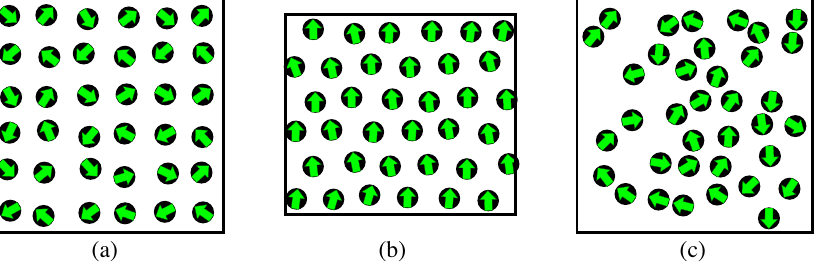
FIG. 1. Ground-state magnetic configurations of representative two-dimensional ensembles of nanoparticles: (a) weakly disordered square structure ( σ r =r 0 ¼ 0 . 05 ), (b) weakly disordered triangular structure ( σ r =r 0 ¼ 0 . 05 ), and (c) nonoverlapping randomly distributed particles. The unit cells are shown, on which periodic boundary conditions